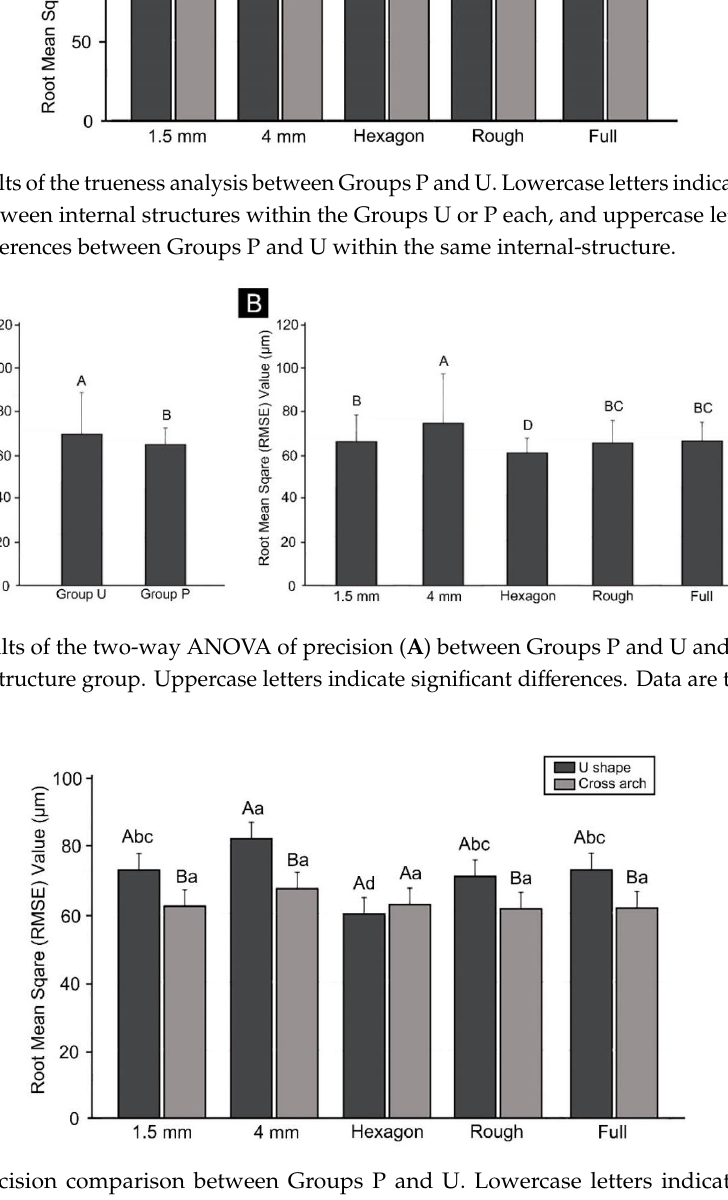
Figure 5. Results of the trueness analysis between Groups P and U. Lowercase letters indicate significant differences between internal structures within the Groups U or P each, and uppercase letters indicate significant differences between Groups P and U within the same internal-structure.